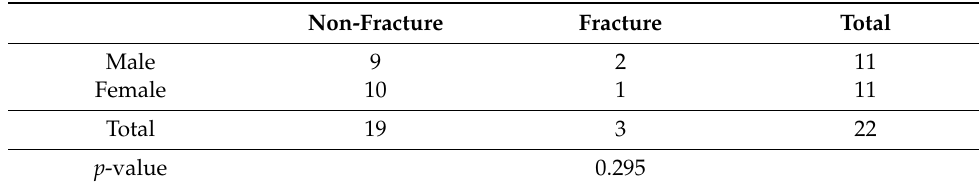
Table 1. Classification of patients by sex.